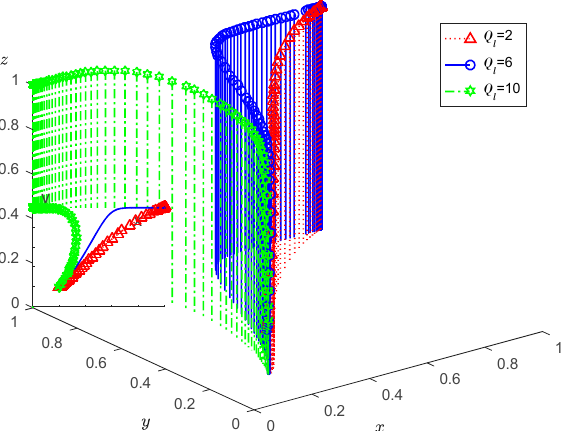
Figure 11. Simulation of evolutionary strategies of producers under different free-riding benefits.